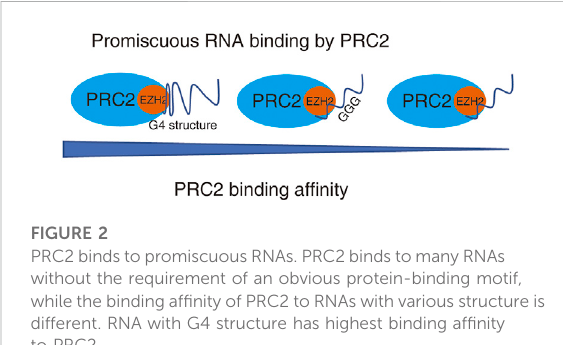
FIGURE 2 PRC2 binds to promiscuous RNAs. PRC2 binds to many RNAs without the requirement of an obvious protein-binding motif, while the binding af fi nity of PRC2 to RNAs with various structure is different. RNA with G4 structure has highest binding af fi nity to PRC2.